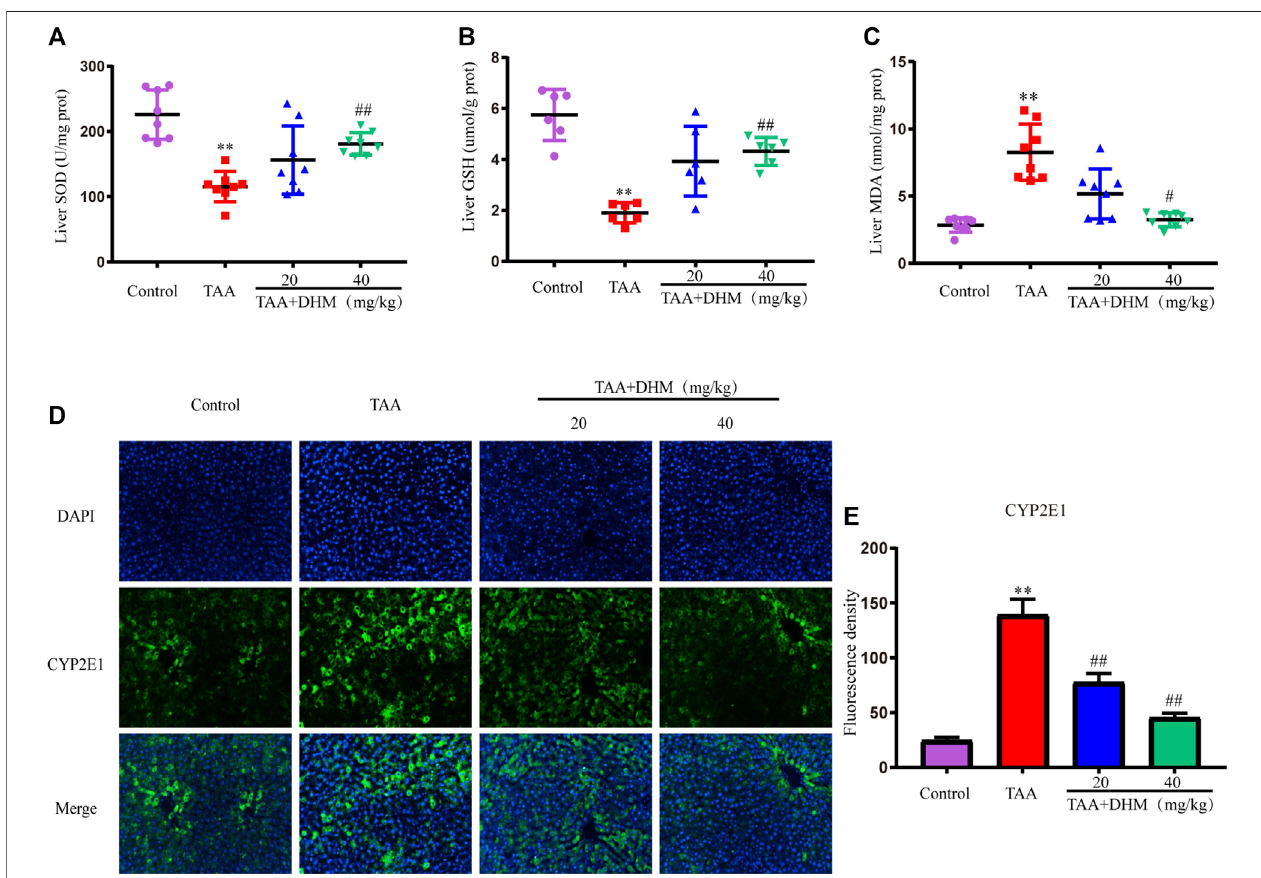
FIGURE 2 | DHM attenuates TAA-induced oxidative stress and hepatotoxicity. The hepatic levels of SOD (E) , GSH (F) and MDA (G) in TAA-induced liver fi brosis ( n (cid:1) 6 – 8); The protein expression levels of CYP2E1 (E) and Fluorescence density (F) ; Data was expressed as the mean ± SD. The differences between groups were analyzed by two tailed T-test or one-way analysis of variance (ANOVA). ** p < 0.01, * p < 0.05 versus control group; ## p < 0.01, # p < 0.05 versus TAA group.